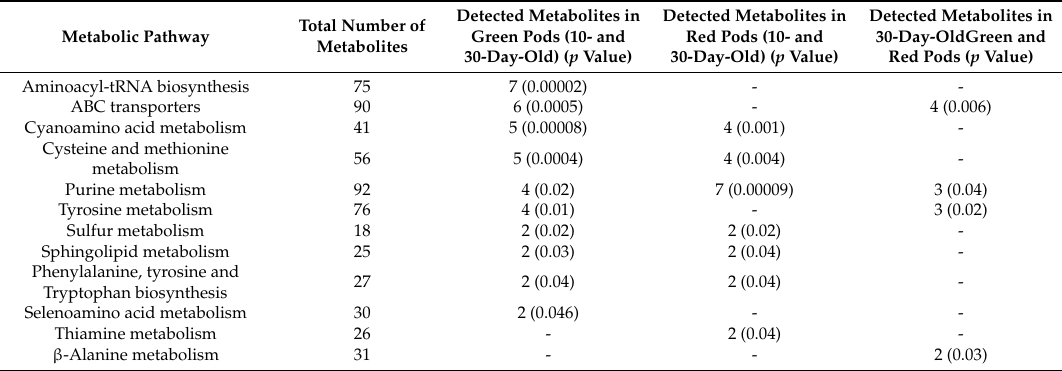
Table 2. Significantly different metabolic pathways 1 of different pods growth stages (10- and 30-day-old) and different color pods (30-day-old green and red pods). Detected Metabolites in Detected Metabolites in Detected Metabolites in Total Number of 30-Day-OldGreen and Red Pods (10- and Green Pods (10- and Metabolic Pathway Metabolites Red Pods ( p Value) 30-Day-Old) ( p Value) 30-Day-Old) ( p Value) Aminoacyl-tRNA biosynthesis 75 7 (0.00002) - - ABC transporters 90 6 (0.0005) - 4 (0.006) Cyanoamino acid metabolism 41 5 (0.00008) 4 (0.001) - Cysteine and methionine 56 5 (0.0004) 4 (0.004) - metabolism Purine metabolism 92 4 (0.02) 7 (0.00009) 3 (0.04) Tyrosine metabolism 76 4 (0.01) - 3 (0.02) Sulfur metabolism 18 2 (0.02) 2 (0.02) - Sphingolipid metabolism 25 2 (0.03) 2 (0.04) - Phenylalanine, tyrosine and 27 2 (0.04) 2 (0.04) - Tryptophan biosynthesis Selenoamino acid metabolism 30 2 (0.046) - - Thiamine metabolism 26 - 2 (0.04) - β -Alanine metabolism 31 - - 2